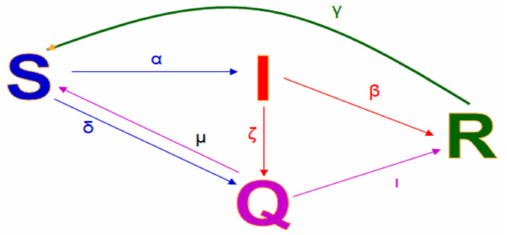
Figure 3. Schematic representation of the CSIRQ model.